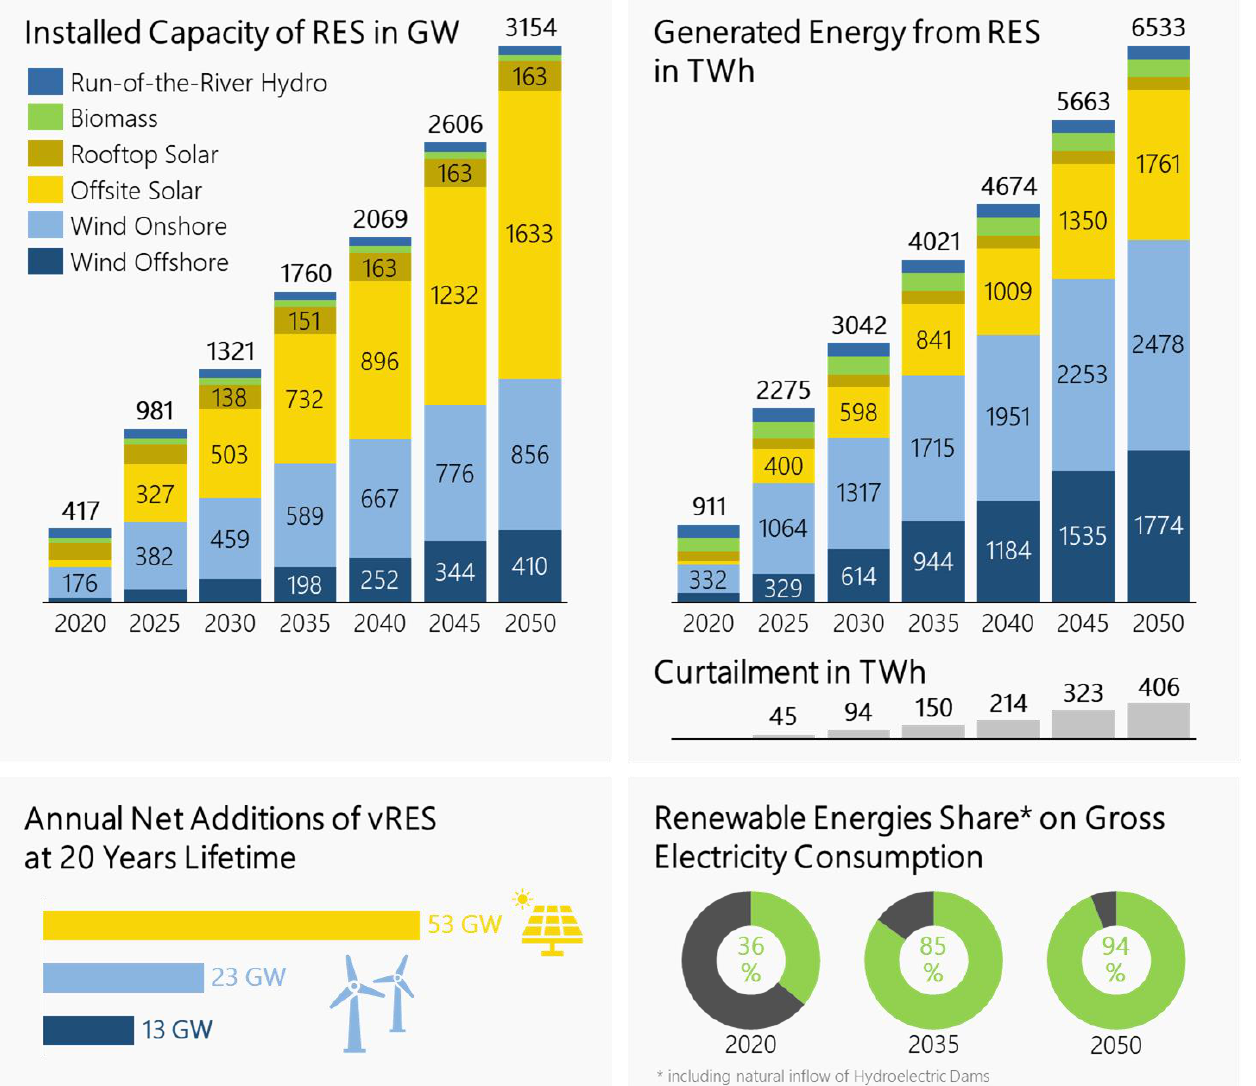
Figure 7. Overview over RES in solidEU [30].